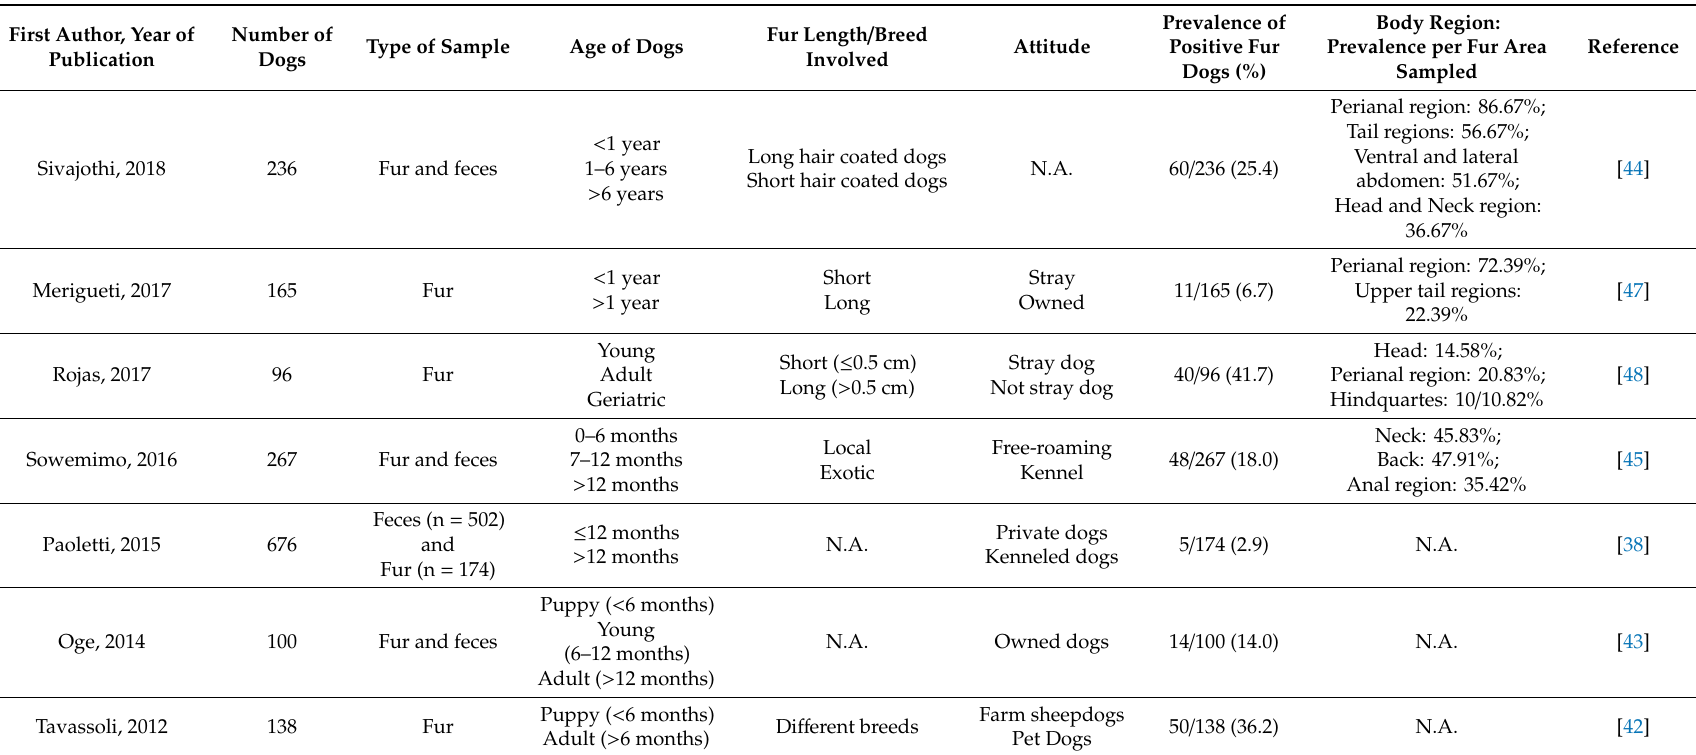
Table 1. Characteristics of the studies concerning the presence of Toxocara eggs on the fur of